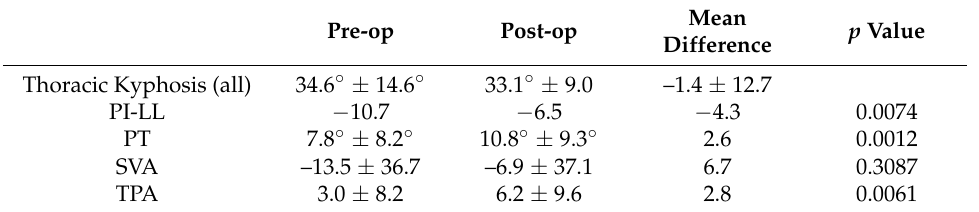
Table 4. Sagittal plane correction